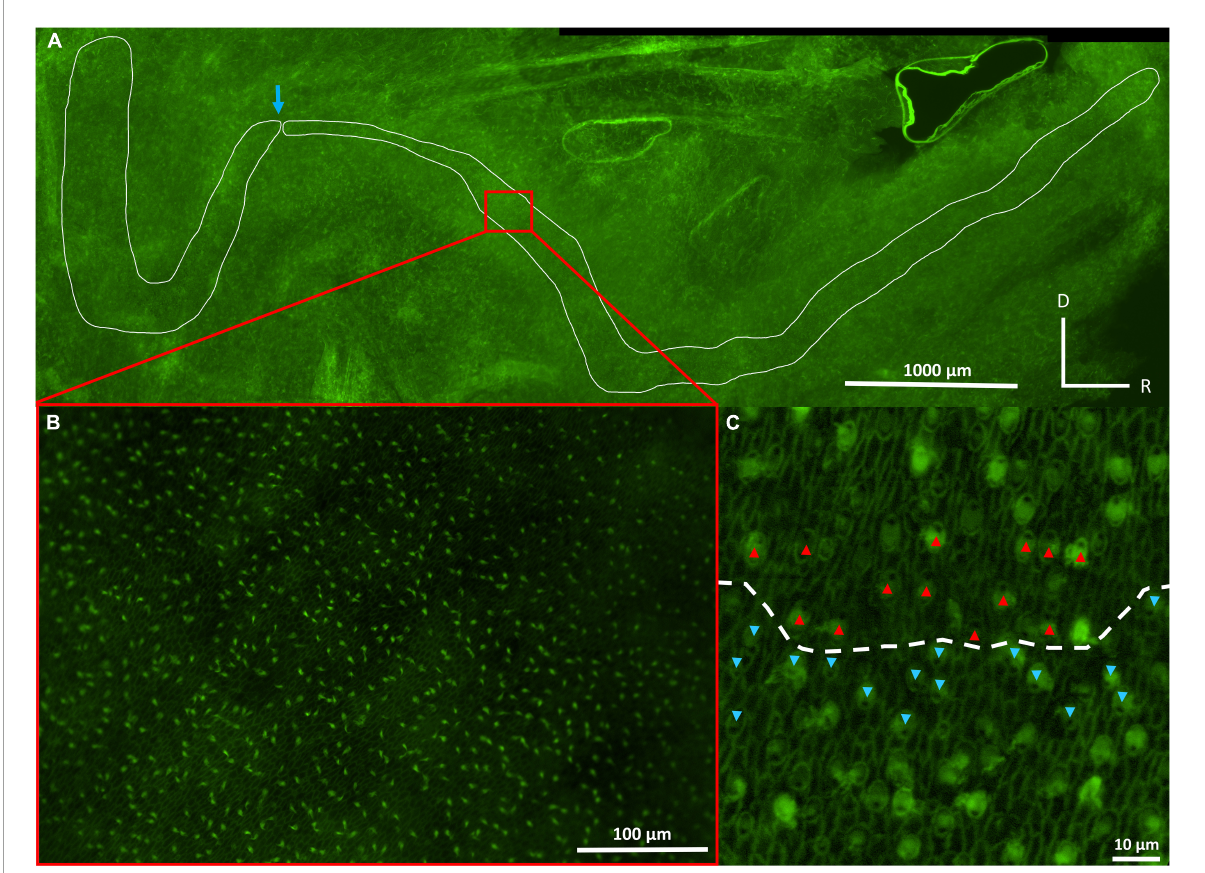
FIGURE2 Photographs of the inner ear maculae of Cephaloscyllium isabellum , showing the saccular (right) and lagenar (left) maculae at 4 × objective (A) , saccular hair cells at 20 × objective (B) , and saccular hair cells at 40 × objective (C) . The blue arrow (A) indicates a natural bend in the lagenar/saccular maculae that was used as an anatomical marker to consistently differentiate and separate the two maculae. The kinocilium of each hair cell, which lacks actin, appears dark relative to the stereocilia (C) . The red and blue arrows (C) indicate the orientation of individual hair cells, which is determined by the location of the kinocilium (dark spot) relative to the stereocilia. The dashed line (C) designates the approximate boundary between two distinct groups of hair cells. D , dorsal; R,